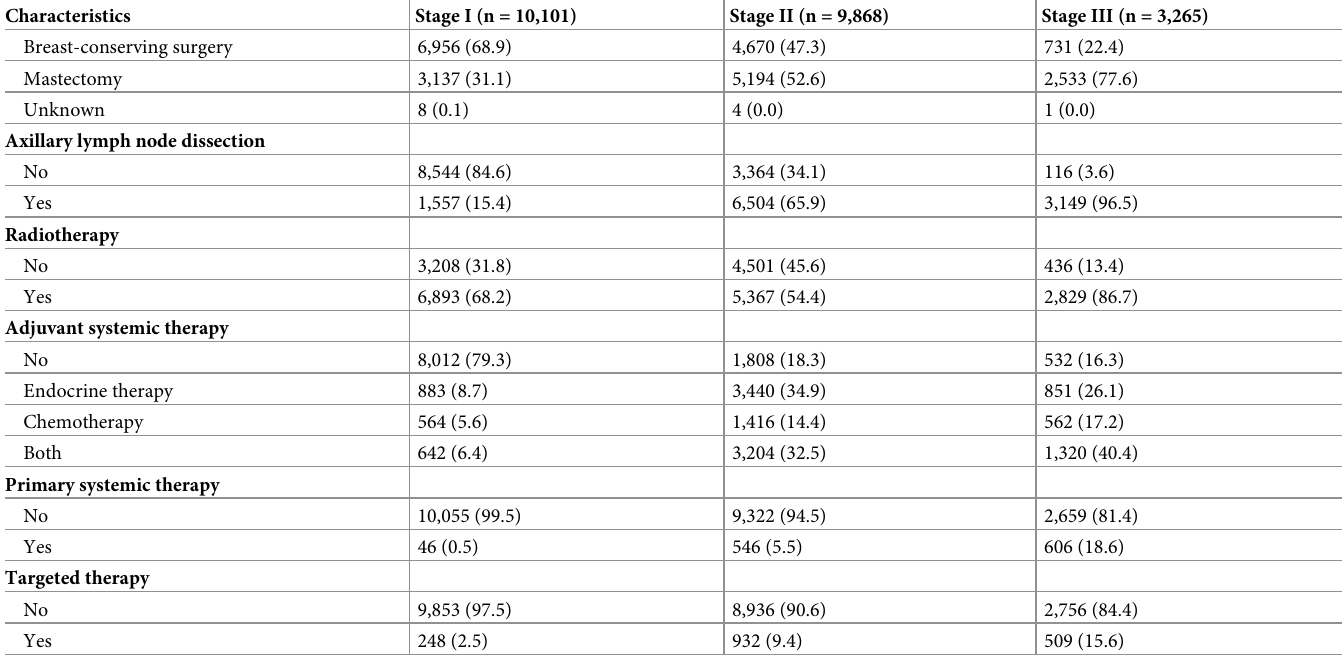
All goodness-of-fit tests for all underlying models were non-significant, indicating no signifi- cant difference between observed and predicted mortality (Table 2). Discrimatory accuracy was moderate to good for all models with AUCs ranging from 0.69–0.90 (Table 2). After boot- strapping, the bias-corrected AUCs ranged from 0.67–0.88 (Table 2), indicating moderate to good discriminatory accuracy for all underlying models as a measure for internal validation. Table 2. Overview of the Hosmer-Lemeshow test, the AUC and the bias-corrected AUC as measures for goodness-of-fit, discriminatory accuracy and internal vali- dation of the models. Stage I (n = 10,101)